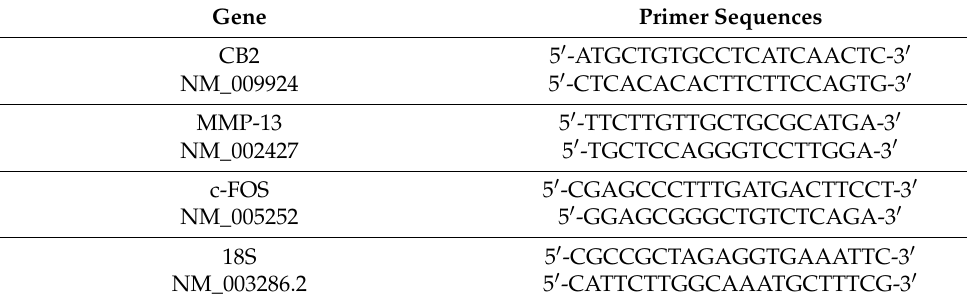
Table 2. Sequences of the primers used in RT-PCR